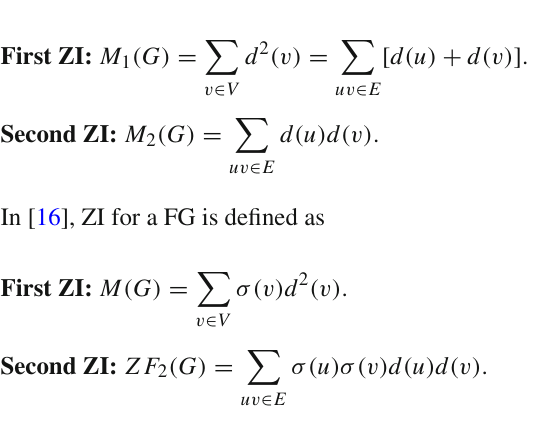
Fig. 1 FI ( G ) (cid:11)= EFI ( G )